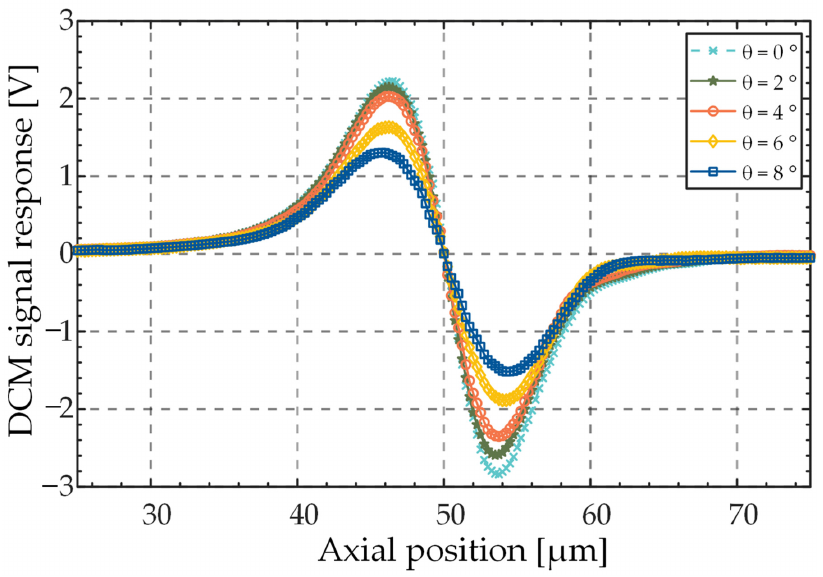
Figure 8. Differential signal curves collected at different tilt